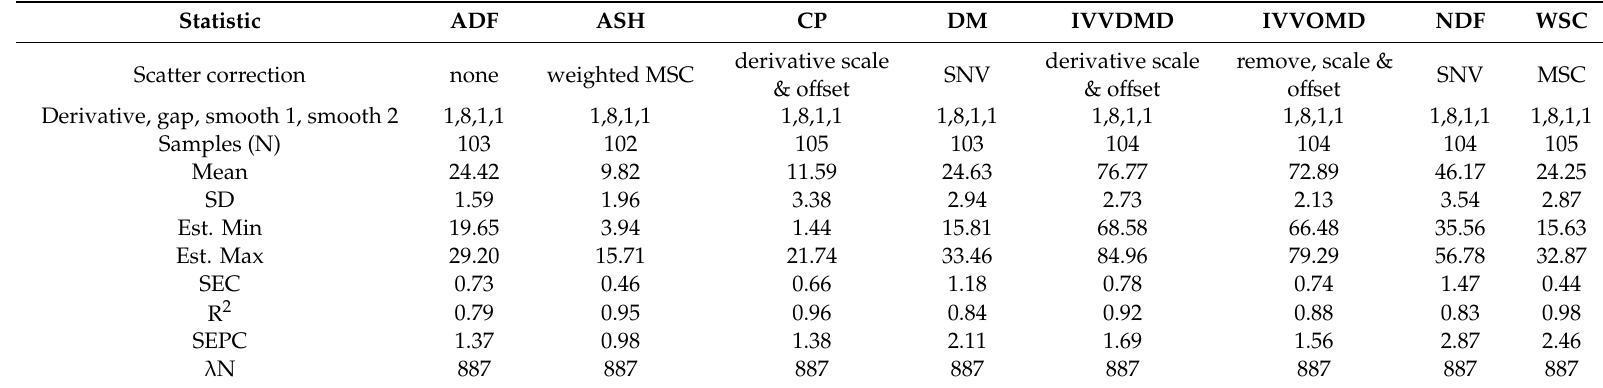
Table 2. Statistics from model created with 70% of the 109 samples with both lab results and spectra (cross validation leave-one-out). Statistics include the mean, standard deviation (SD), the estimated minimum (Est.Min) and maximum (Est.Max), standard error of covariance (SEC), standard error of prediction (SEP) the coe ffi cient of determination (R 2 ), and standard error of prediction covariance (SEPC) and the number of wavelengths included in the model ( λ